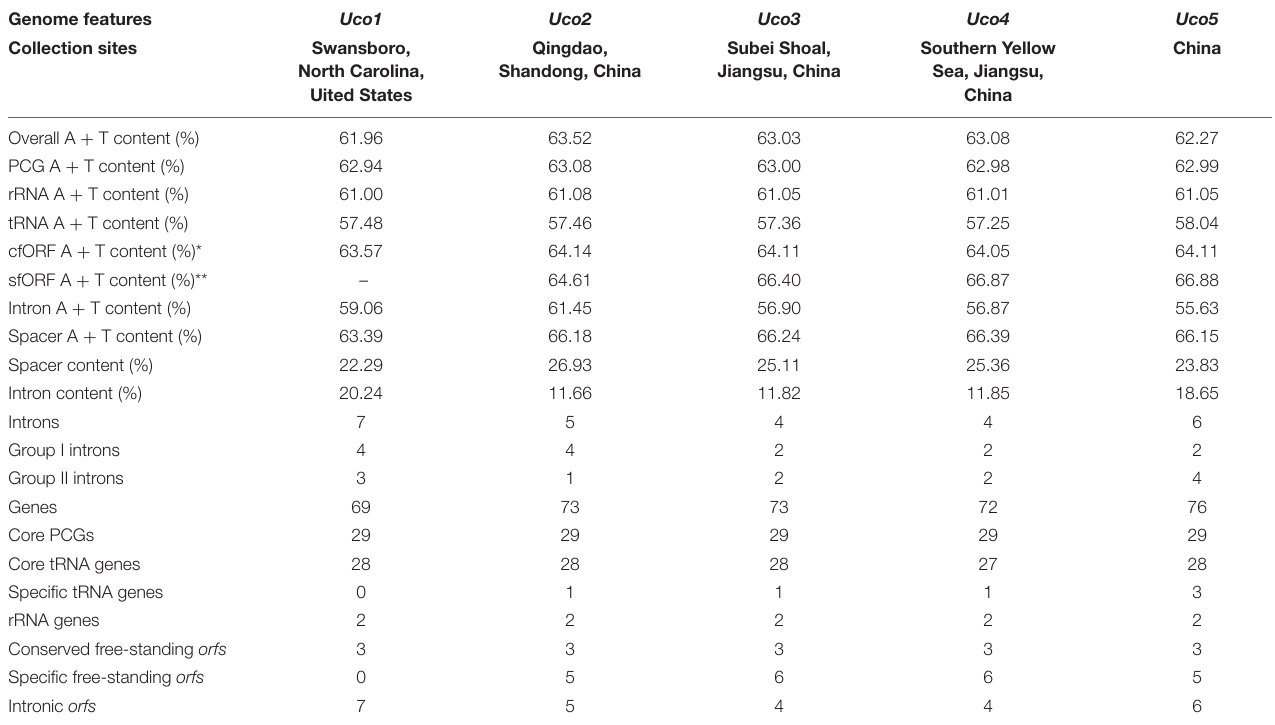
TABLE 2 | Comparison of genome features in the five mitochondrial genomes of Ulva compressa ( Uco1 – 5 ). Genome